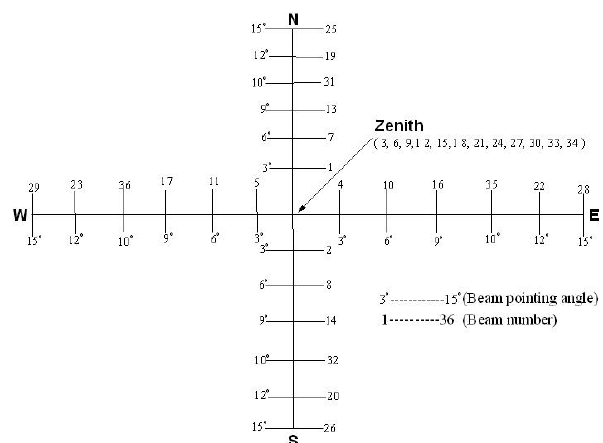
Fig. 1. Beam switching pattern in E–W and N–S planes of the an- tenna array, used for the present study of aspect sensitivity. The beam scan number and zenith angle of the beam are also